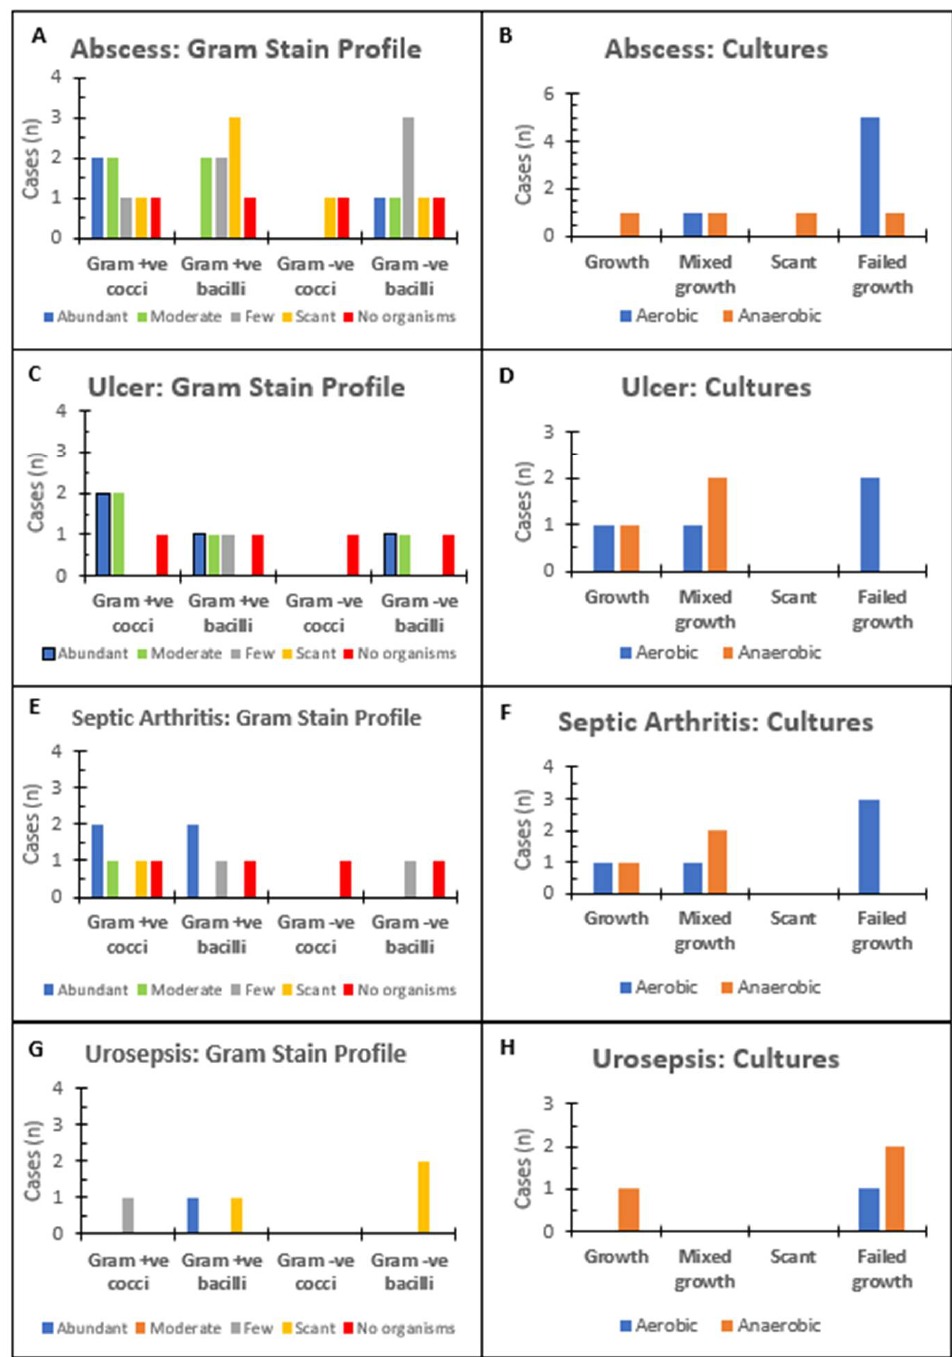
Figure 1. Summary of microbiology tests for samples sent for each of the infections: ( A ) Gram stain profile for abscess samples; ( B ) culture results for abscess samples; ( C ) Gram stain profile for ulcer samples; ( D ) culture results for ulcer samples; ( E ) Gram stain profile for septic arthritis samples; ( F ) culture results for septic arthritis samples; ( G ) Gram stain profile for urosepsis samples; and ( H ) culture results for urosepsis samples.